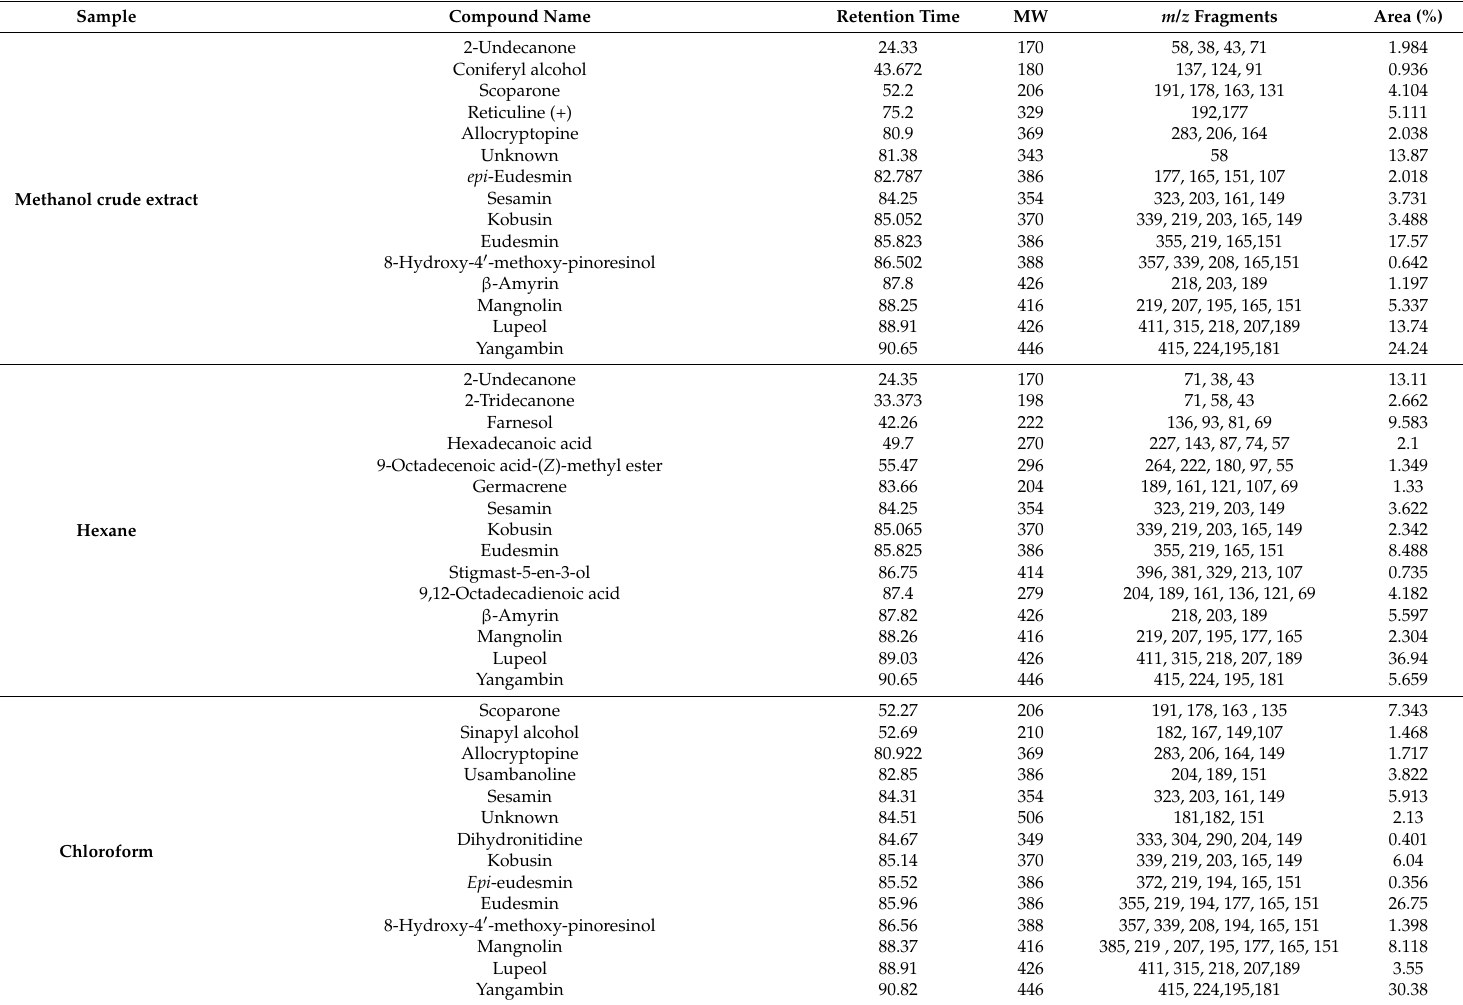
Table 1. Compounds identified in various solvent fractions of Z. rhetsa using GC-MS analysis.